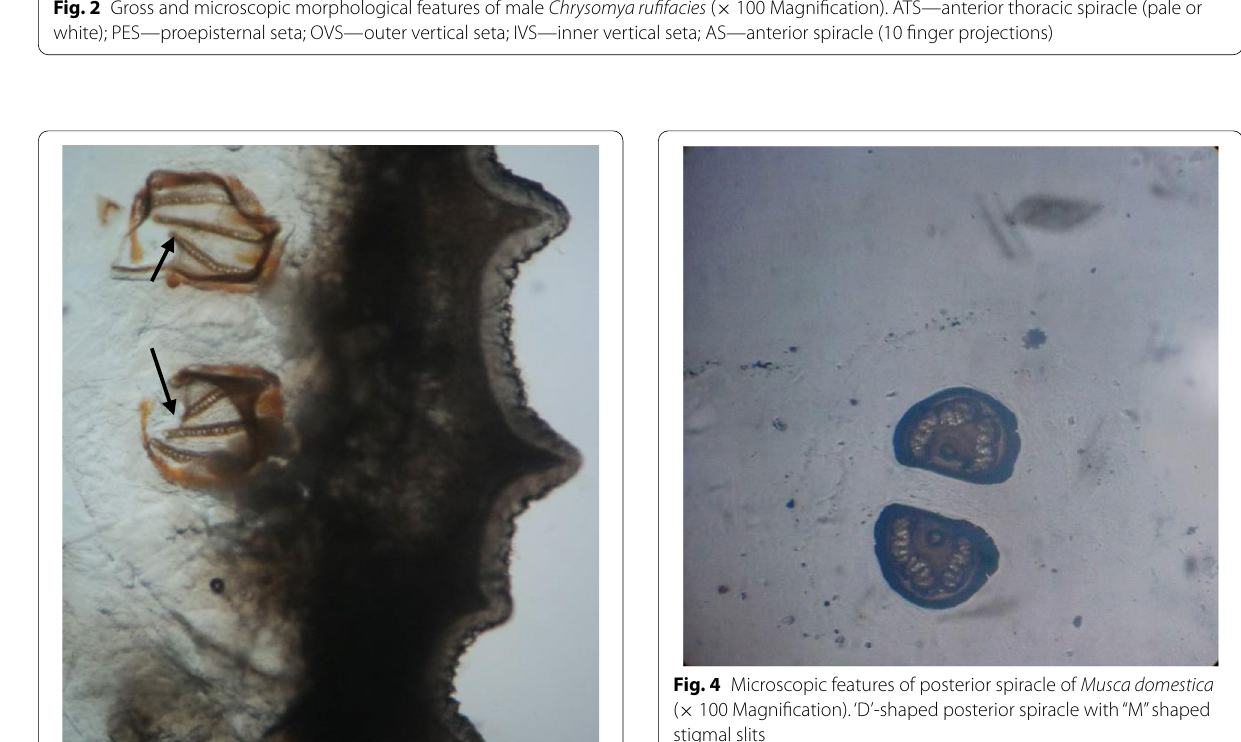
100 Magnification). ATS—anterior thoracic spiracle (pale or ×